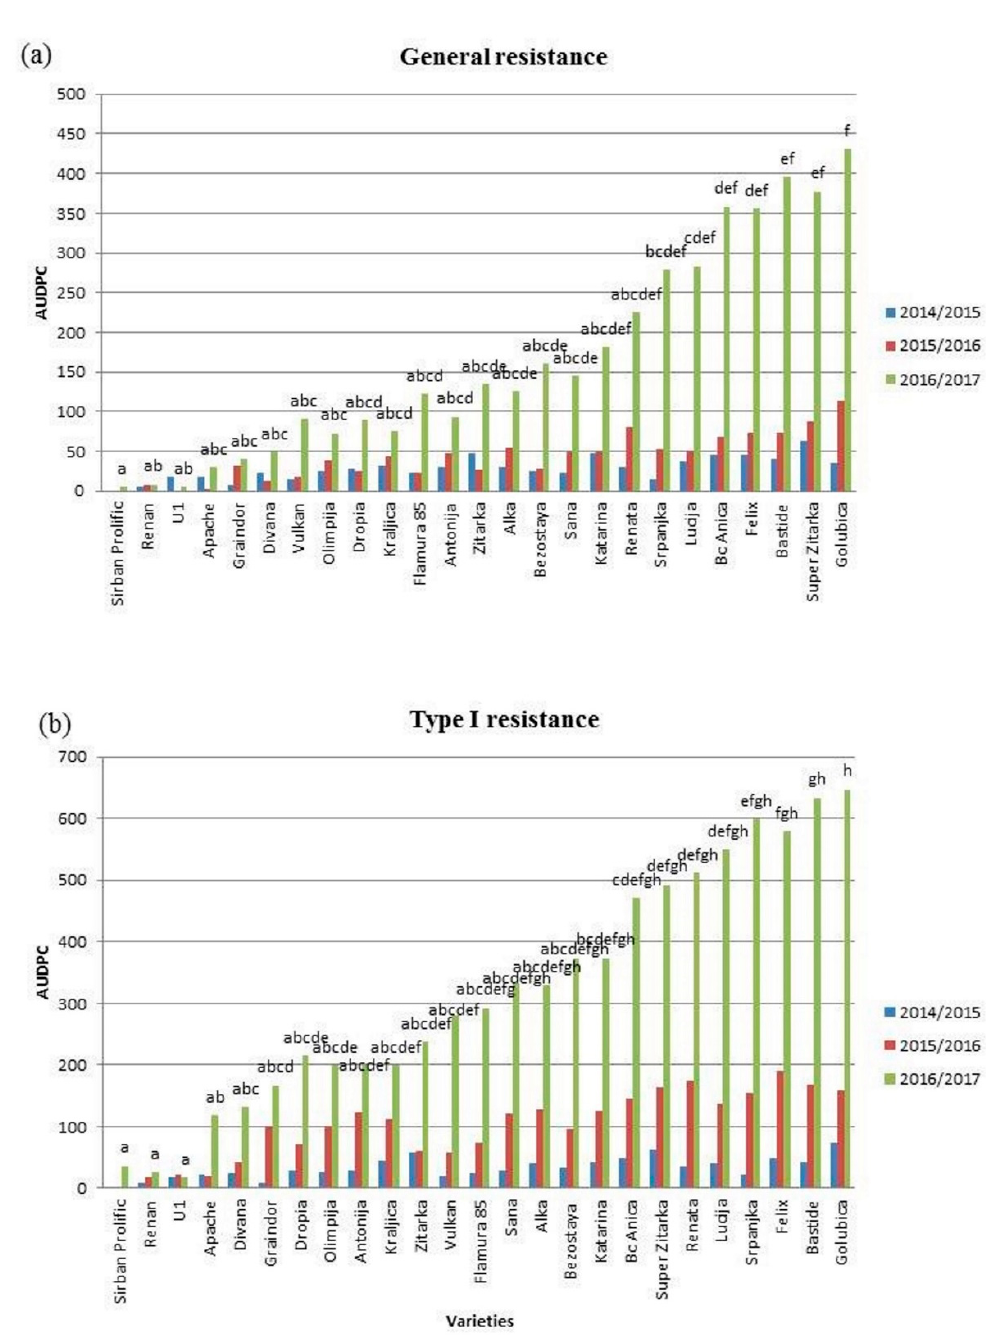
Figure 3. AUDPC for general FHB resistance ( a ) and Type I resistance ( b ) in the three examined years for 25 winter wheat varieties. Different lower-case letters represent significantly different values ( p < 0.05) for each wheat variety in the three years in average.